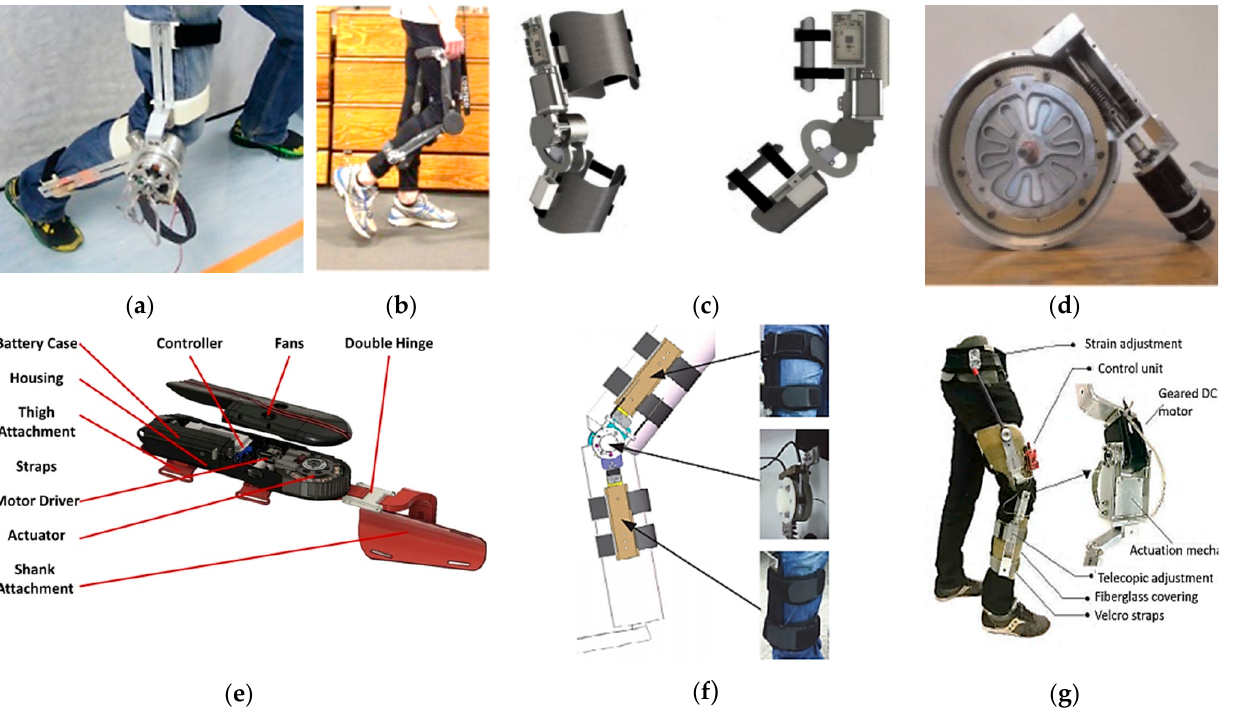
Figure 7. Knee Orthesis Structures: ( a ) Karavas et al., 2013 [35], ( b ) Elliott et al., 2014 [41], ( c ) Cantu et al., 2017 [34], ( d ) Dos Santos et al., 2015 [42], ( e ) Zhu et al., 2019 [29], ( f ) Shan et al., 2016 [31], ( g ) Claros et al., 2016